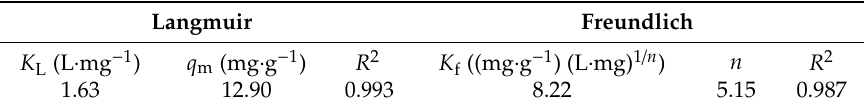
Table 1. The fitting parameters by the Langmuir model and Freundlich model for Li + onto MCM- g - AB15C5.